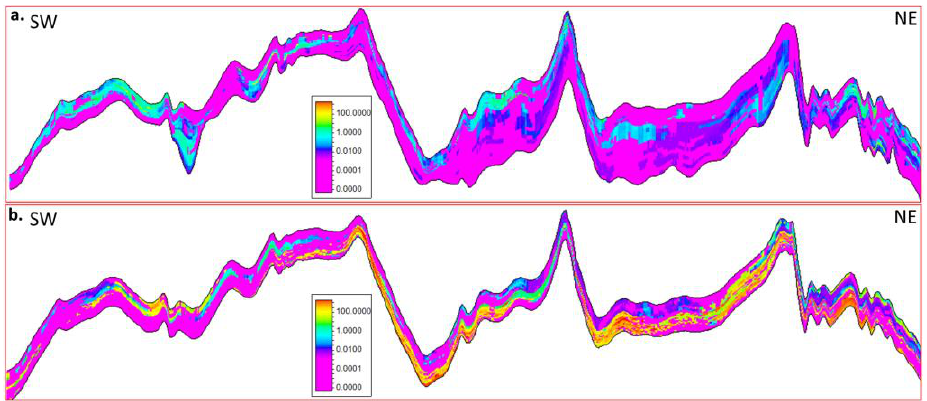
Figure 22. SW – NE intersections of permeability model of Unit 4 ( a ) and Unit 5 ( b ). The permeability shows inverse variation trends in Unit 4 and Unit 5. The permeability has an increasing trend from south to north in Unit 4, while it has a decreasing trend from south to north in Unit 5.